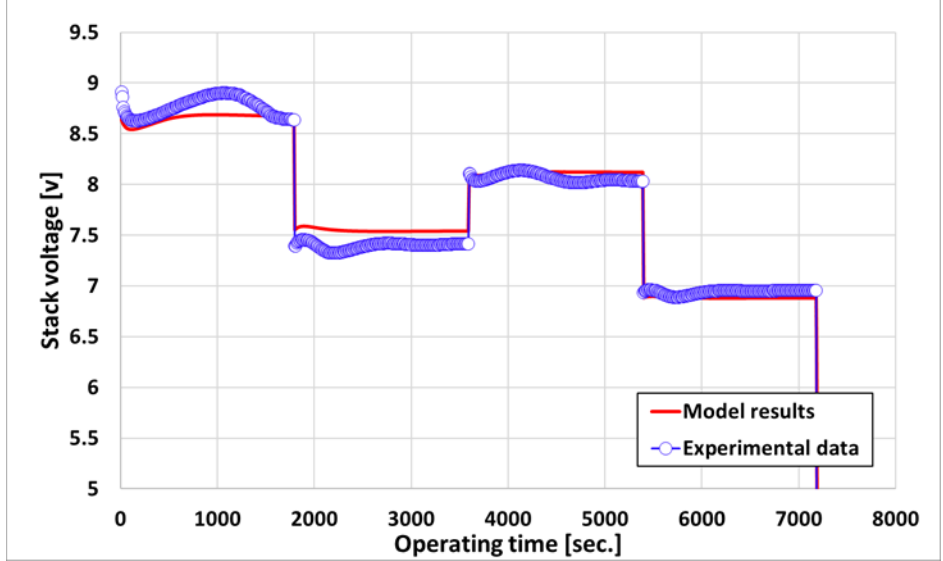
Figure 6. Voltage transient response by current load